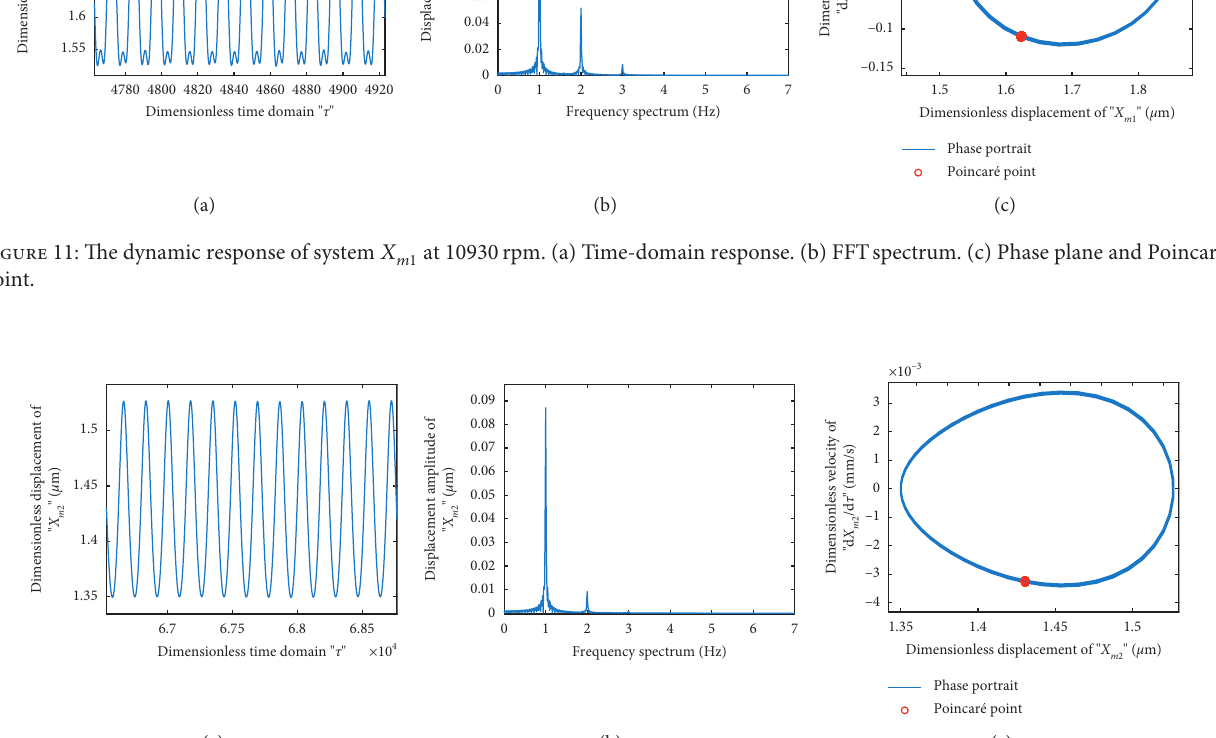
Figure 12: The dynamic response of system X